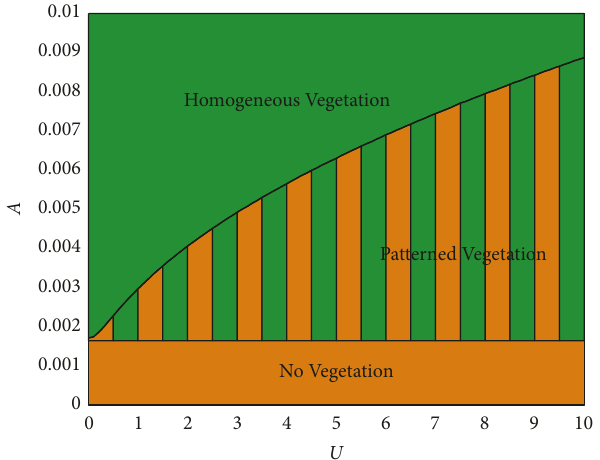
Figure 3: Region diagram corresponding to parameters 𝐴 and 𝑈 . Three areas are divided: areas of no vegetation, patterned vegetation, and homogeneous